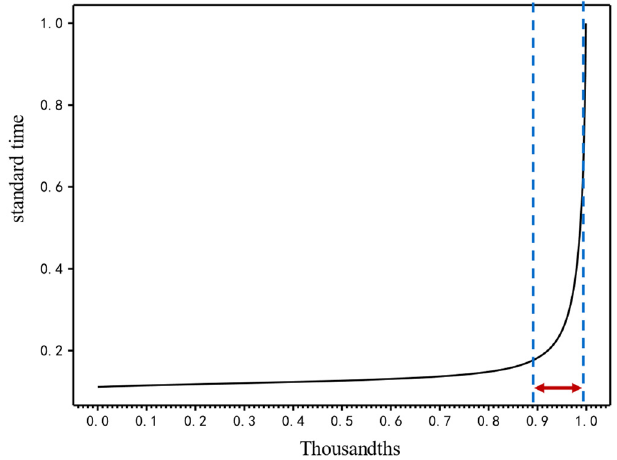
Figure 4. Overall average travel time distribution.